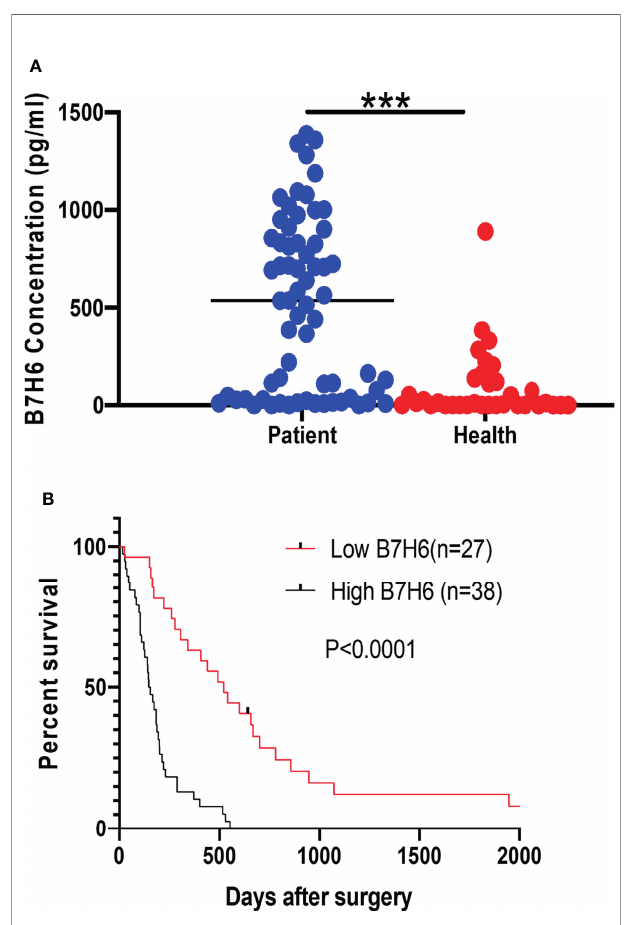
FIGURE 2 | Relationship between soluble B7H6 expression in serum and prognosis for PC patients. (A) sB7H6 levels in serum of PC patients (n=65) and healthy donors (n=34). Data are from at least 3 independent experiments. (B) Kaplan-Meier analysis of overall survival of PC patients grouped by B7H6 levels, using the median (219.5pg/mL) as a cut-off (*** P <